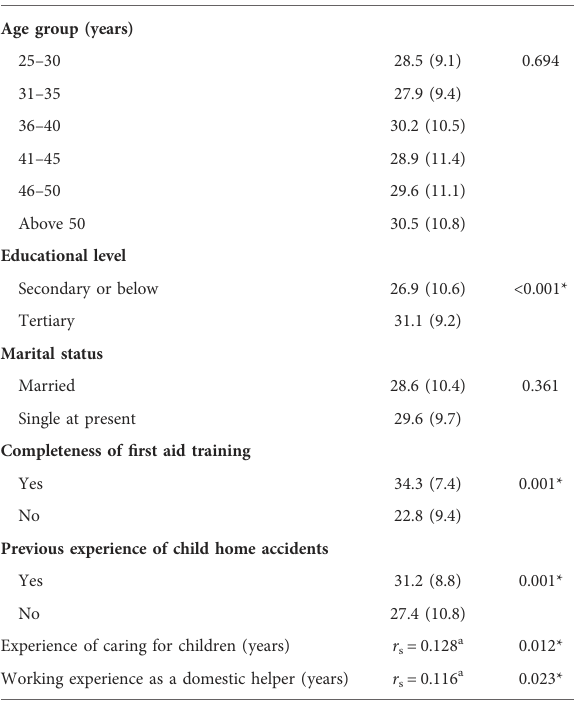
TABLE 3 Bivariate analysis of the relationships between personal characteristics and